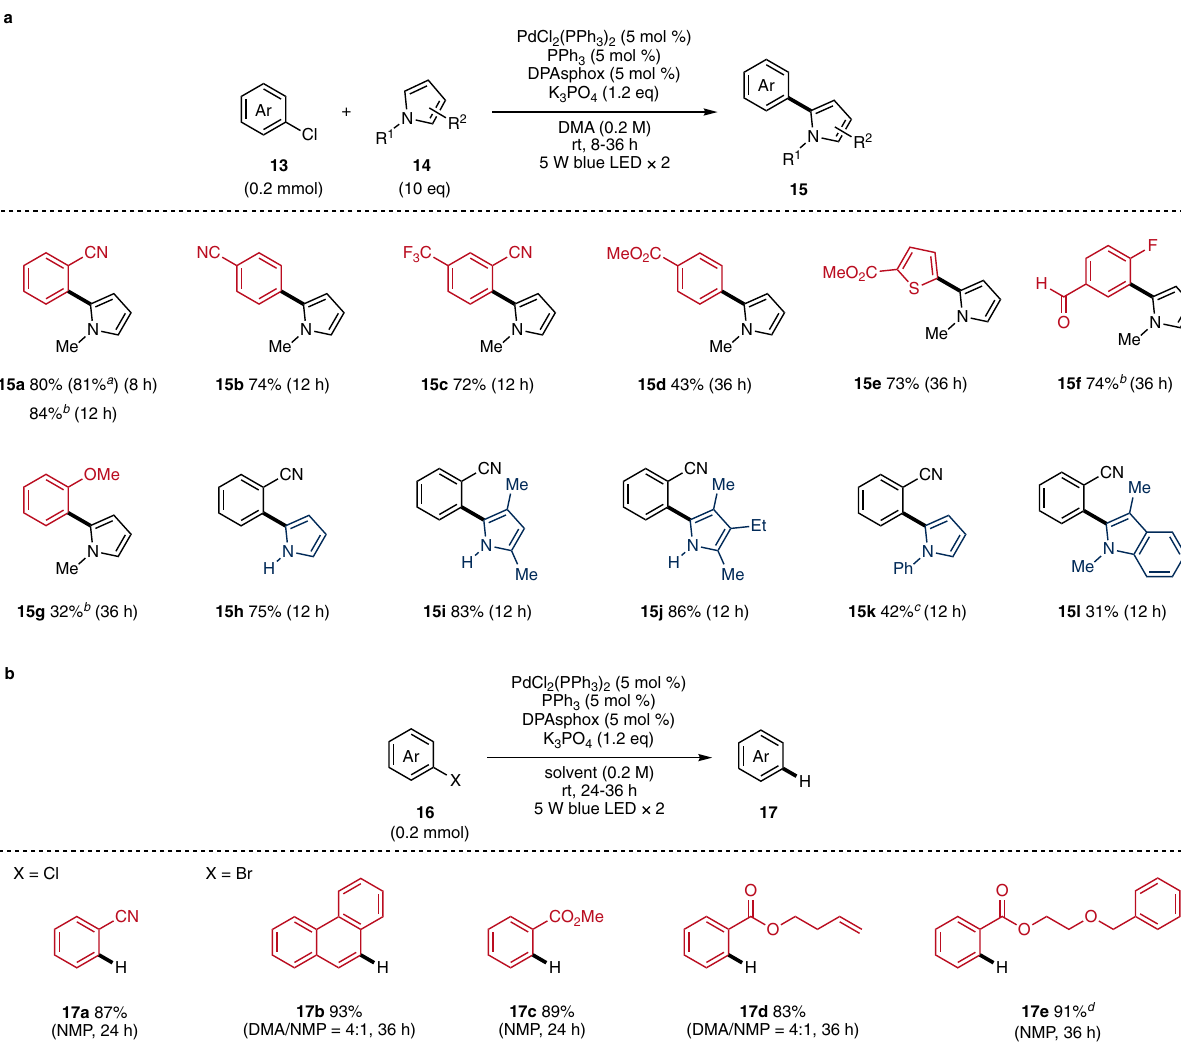
Fig. 5 Pd-catalyzed biaryl synthesis and dehalogenative hydrogenation. a Substrate scope of biaryl synthesis. b Substrate scope of dehalogenative hydrogenation. a 1.0 mmol scale. b Aryl bromide was used as a substrate. c N -phenylpyrrole (5 equiv.) was used. d Solvent (0.1 M) was used. DMA N , N - dimethylacetamide, NMP N